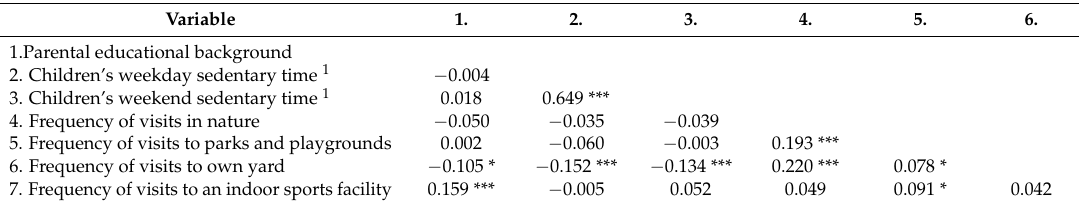
Table 2. Spearman correlations between the measures used in the study (listwise N =